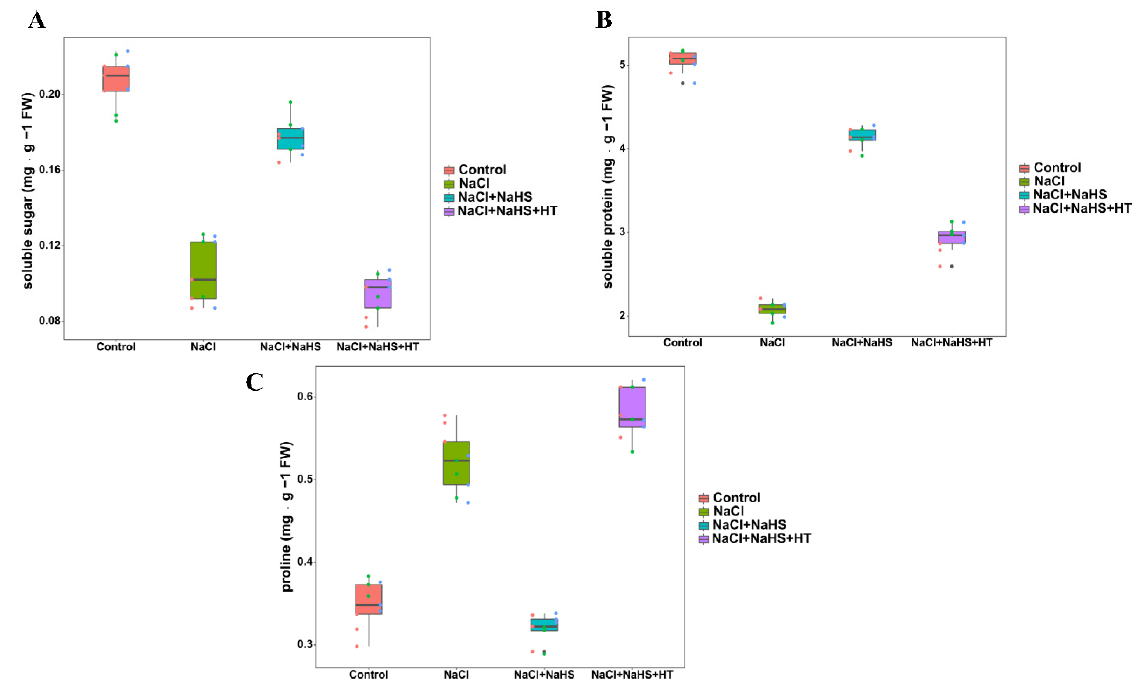
Figure 4. Effect of NaHS application on soluble sugar content ( A ), soluble protein content ( B ), and proline content ( C ) of explants species. The primary roots were removed from hypocotyl of 5-day-old seedlings. Explants were incubated for 5 days with distilled water (the control), NaCl, NaCl + NaHS, NaCl + NaHS + HT. Values are means of three independent replicates.